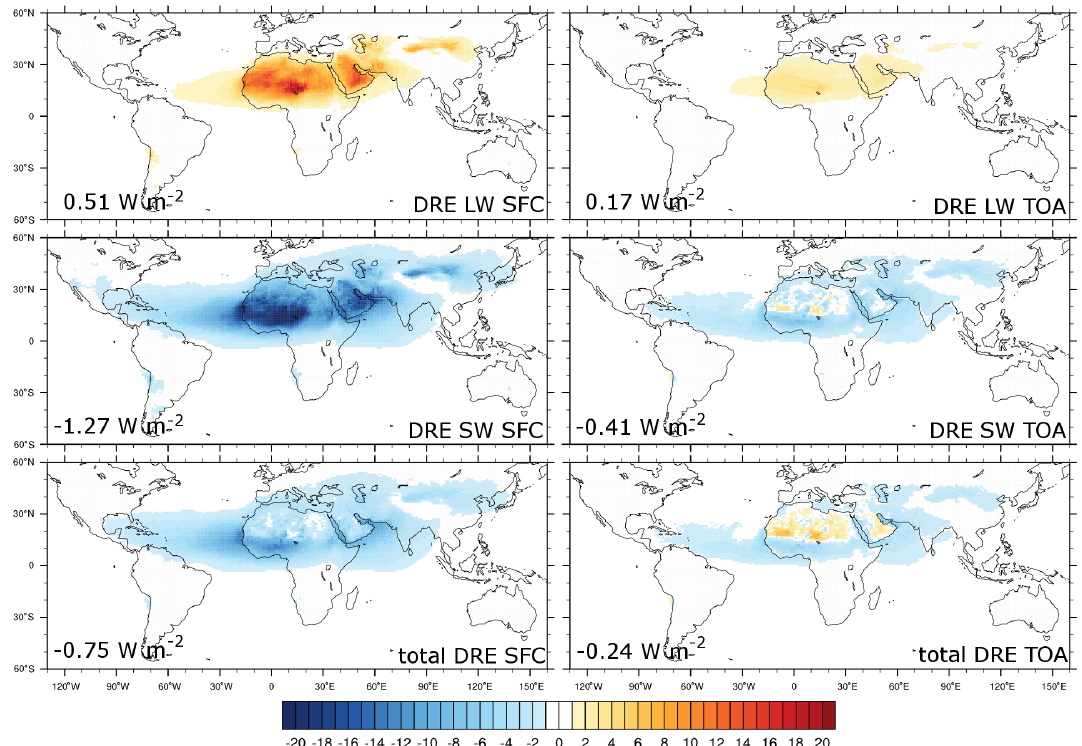
Figure 10. Annual average longwave, shortwave, and total direct radiative effect [Wm − 2 ] at the surface (SFC) and the top of the atmosphere (TOA) obtained from MONARCH as average across the four runs. Global average values are indicated in each panel.